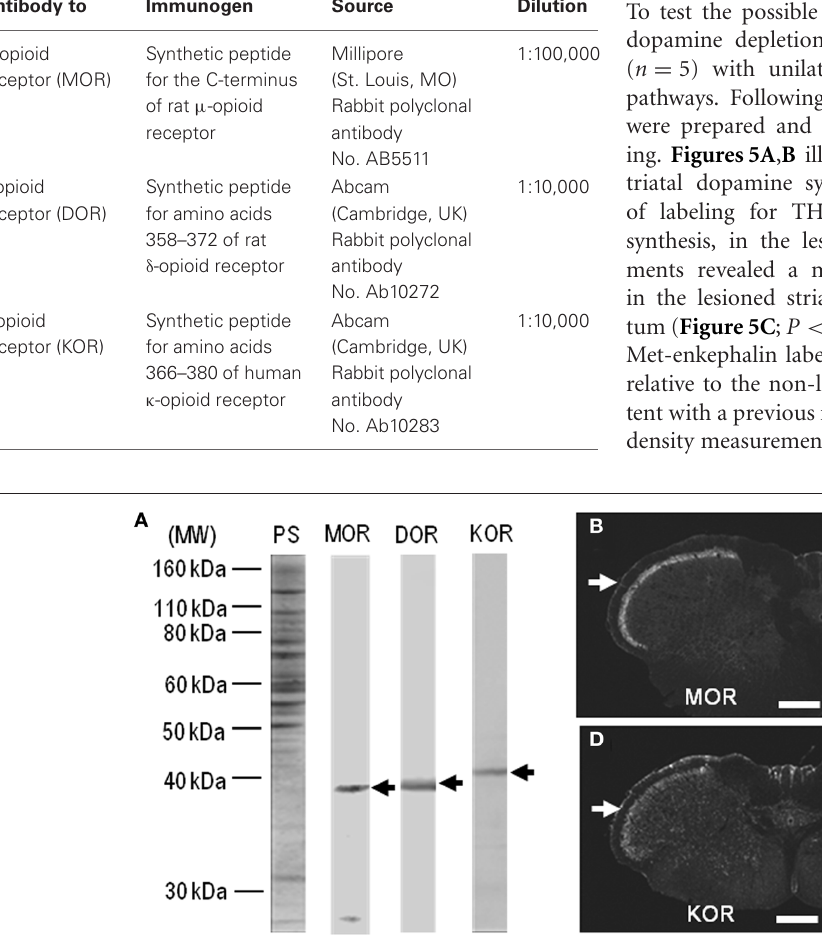
FIGURE 1 | Characterization of antibodies against opioid receptors. (A) Rat striatal extracts (10 μ g of protein) treated with Endo- β - N -acetyl-glucosaminidase F1 (100 milliunits/ml) (see Materials and Methods) were subjected to trans-immunoblots using the antibodies against MOR, DOR, and KOR. Arrows indicate immunoreactive protein bands. MW, molecular weight; PS, protein